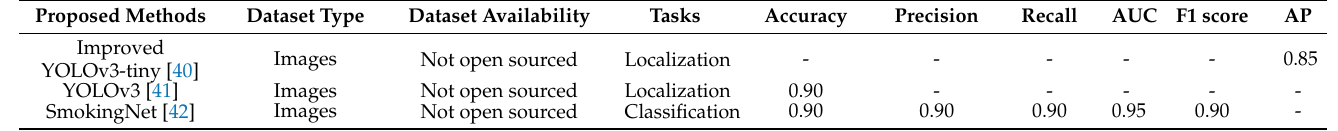
Table 1. Comparative analysis of the computer vision-based smoker detection methods.